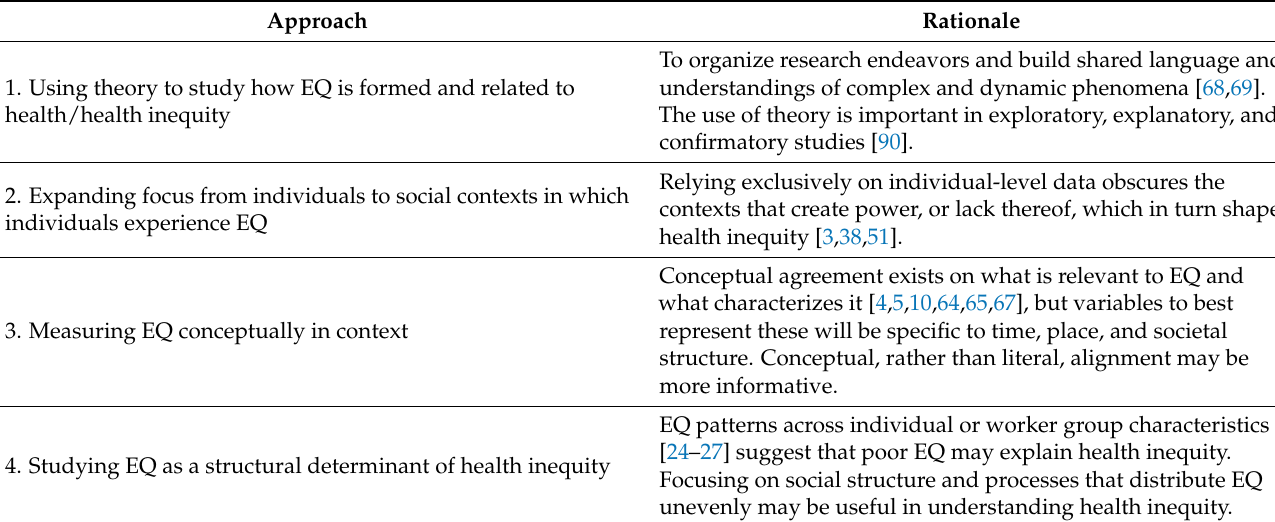
Table 2. Approaches to incorporate a perspective of power in the research on employment quality (EQ) and